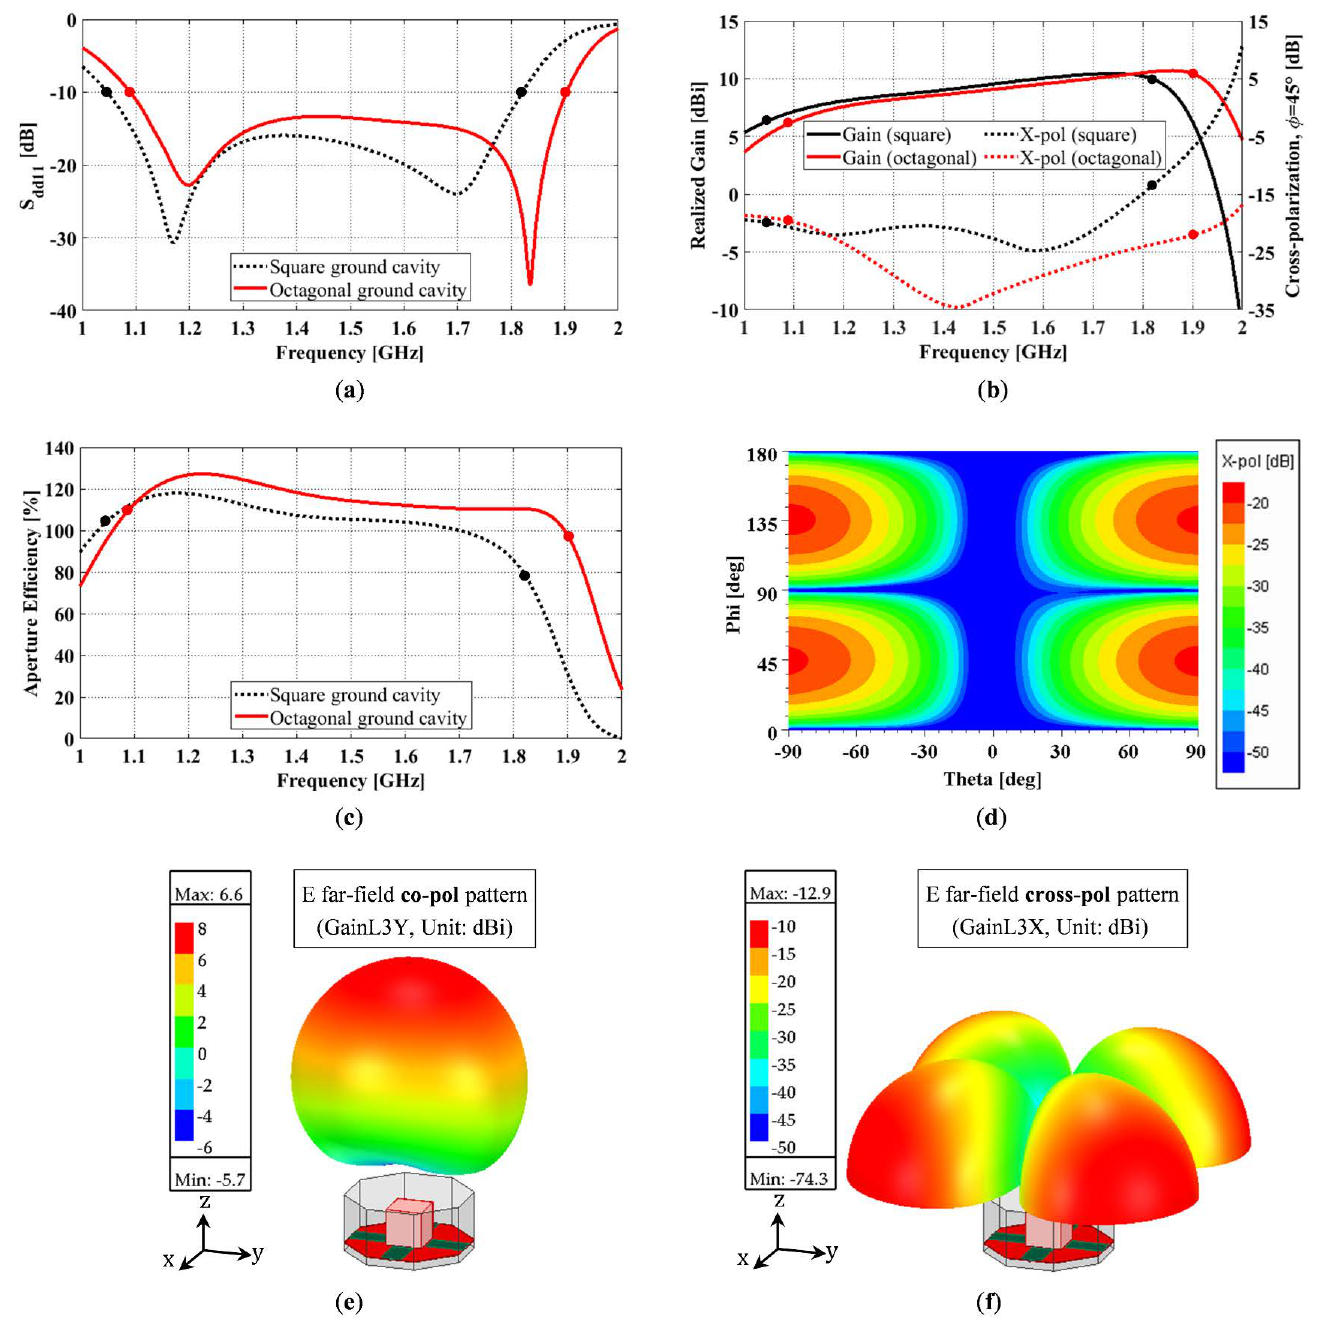
Figure 3. Square and octagonal ground cavity-backed radiating open prism antennas: ( a ) Differential reflection coefficient; ( b ) Realized gain and peak cross-polarization; ( c ) Aperture efficiency; ( d ) Cross- polarization ratio of OCROP for 1.1 GHz at all azimuth and elevation angles of interest; ( e ) 3D far-field co-polarized radiation pattern of the octagonal cavity-backed antenna at 1.1 GHz; ( f ) 3D far-field cross-polarized radiation pattern of the octagonal cavity-backed antenna at 1.1 GHz. (Black and red dots mark the lower and upper limits of the two S dd11 ≤ − 10 dB operating